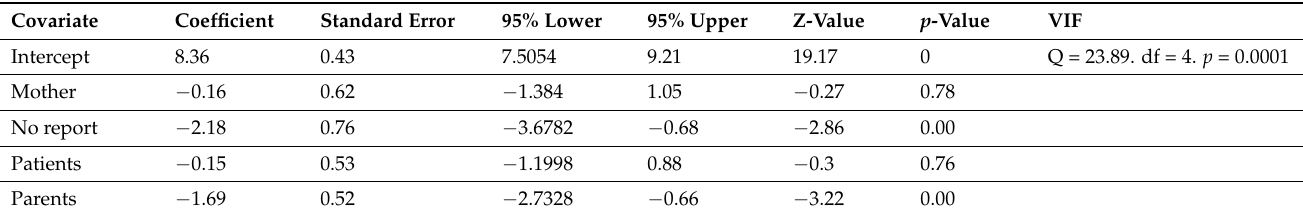
Table 4. Meta-regression by informant.